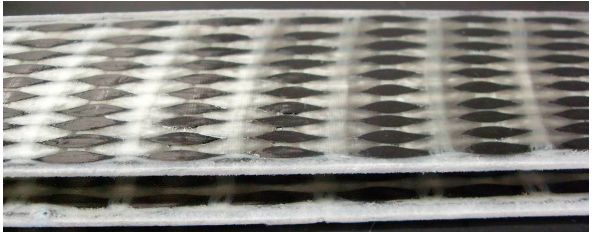
Figure 3: Carbon fibre smart textile specimen for strengthening of structures with function of real time strain monitoring.